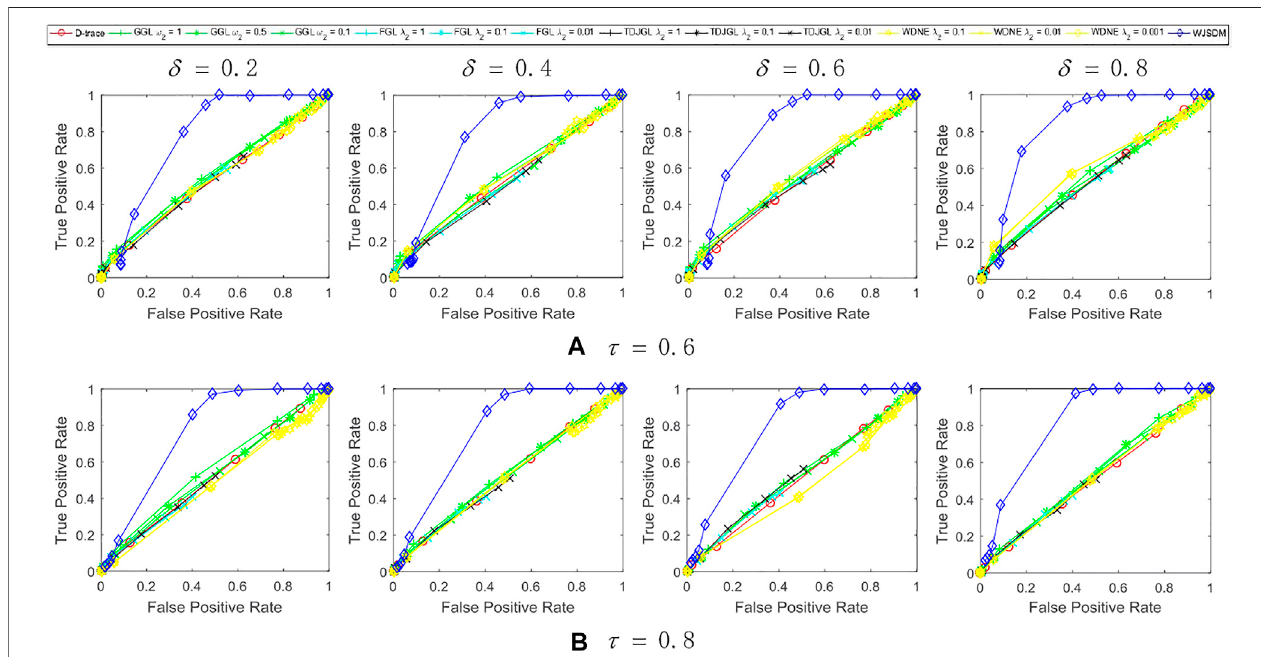
FIGURE 1| Performance ofWJSDM, D-trace, GGL, FGL, TDJGL and WDNE with p (cid:1) 100, K (cid:1) 3, n (cid:1) 50 and missing rate (A) τ (cid:1) 0.6, (B) τ (cid:1) 0.8. Within each plot, eachlinepresentstheperformanceofamethodwiththevalueof λ (forWJSDMandD-trace), λ 1 (forFGL,TDJGLandWDNE)or ω 1 (forGGL)varyingfora fi xedvalueof λ 2 (for FGL, TDJGL and WDNE) or ω 2 (for GGL). Each curve is obtained by averaging the performance of a method over ten random generations of